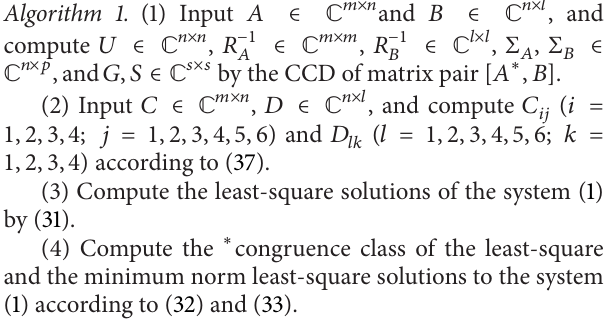
Algorithm 1. (1) Input 𝐴 ∈ C 𝑚×𝑛 and 𝐵 ∈ C 𝑛×𝑙 ,